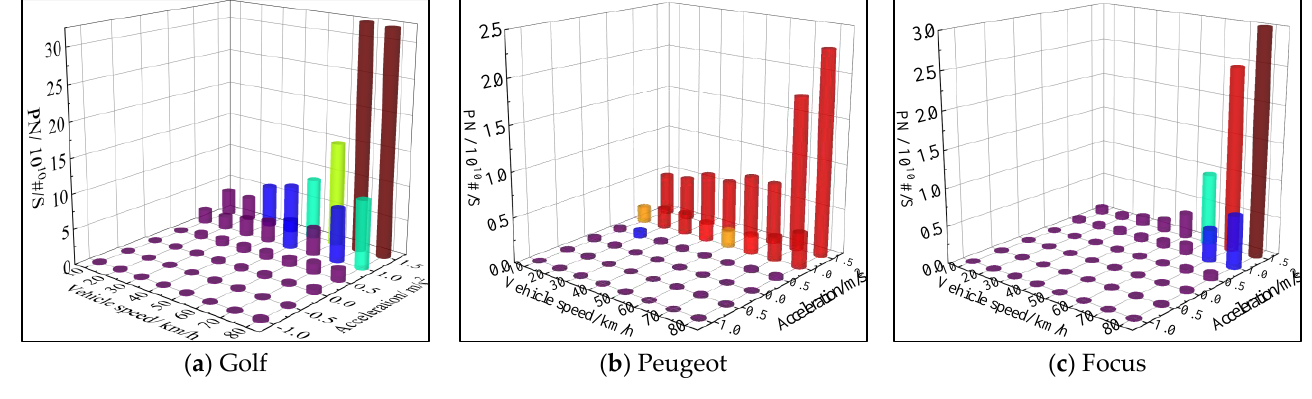
Figure 5. PN emission rates vs. vehicle speed and acceleration.